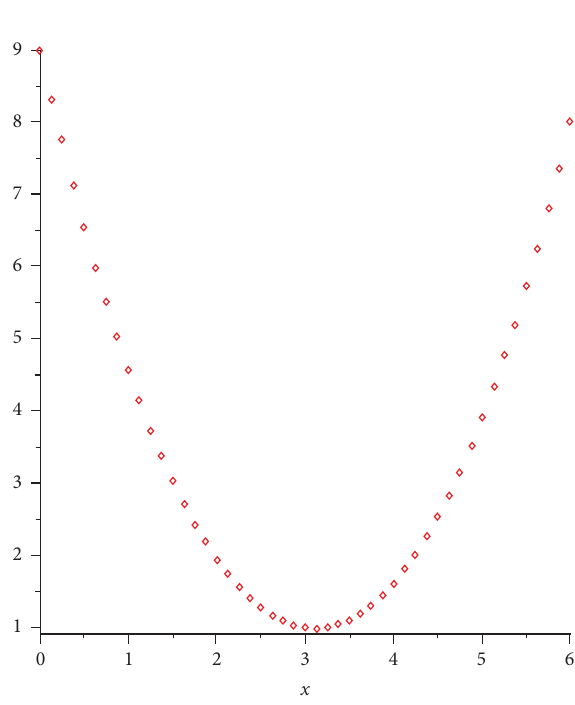
Figure 5: Concentration of the points.